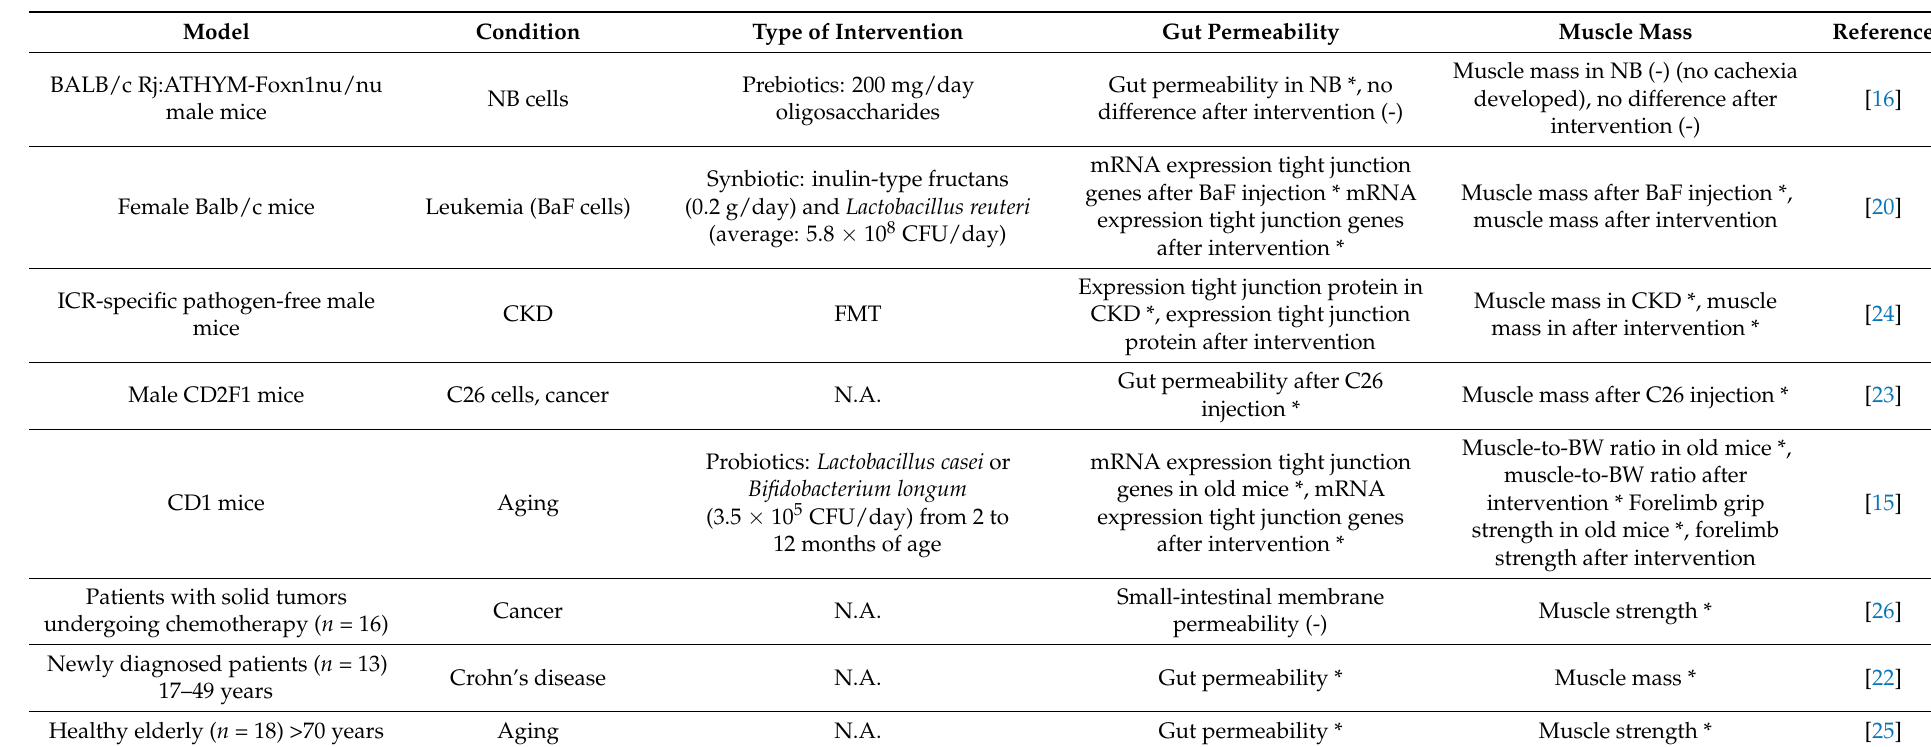
Table 2. Characteristics and results of the studies included in the systematic research on the relationship between gut permeability and muscle